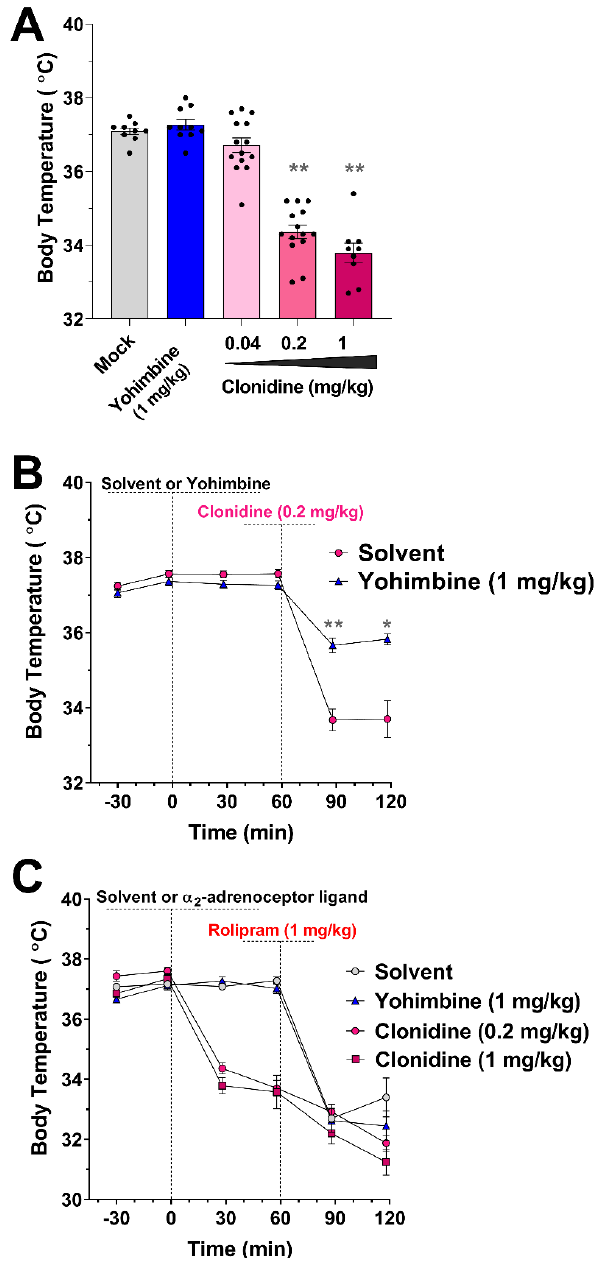
Figure 6. Agonism at α 2 -adrenoceptors induces hypothermia, but neither agonism nor antago- nism of α 2 -adrenoceptors protects from PDE4 inhibitor-induced hypothermia in mice. ( A ) The effect of treatment with the α 2 -adrenoceptor antagonist Yohimbine (1 mg/kg; i.p.) or the α 2 - adrenoceptor agonist Clonidine (0.04, 0.2 and 1 mg/kg; i.p.) on core body temperature measured 30 min after drug injection. Each dot represents a different animal. ( B ) Pre-treatment with the α 2 -adrenoceptor antagonist Yohimbine (1 mg/kg; i.p., at 0 min) protects from hypothermia induced by the α 2 -adrenoceptor agonist Clonidine (administered i.p. 60 min after pretreatment) ( n = 8). ( C ) Neither pre-treatment with the α 2 -adrenoceptor antagonist Yohimbine (1 mg/kg; i.p.) nor the α 2 - adrenoceptor agonist Clonidine (0.2 or 1 mg/kg; i.p.) protects from or alters PDE4 inhibitor-induced hypothermia (Rolipram, 1 mg/kg, administered i.p. at 60 min after pretreatment) ( n = 8). All data represent the mean ± SEM. Statistical significance was determined using the Kruskal–Wallis test and Dunn’s post hoc test for the bar graph in ( A ) and using two-way ANOVA with Sidak’s post hoc test for the time courses in ( B , C ) and is indicated as * ( p < 0.05), or ** ( p <